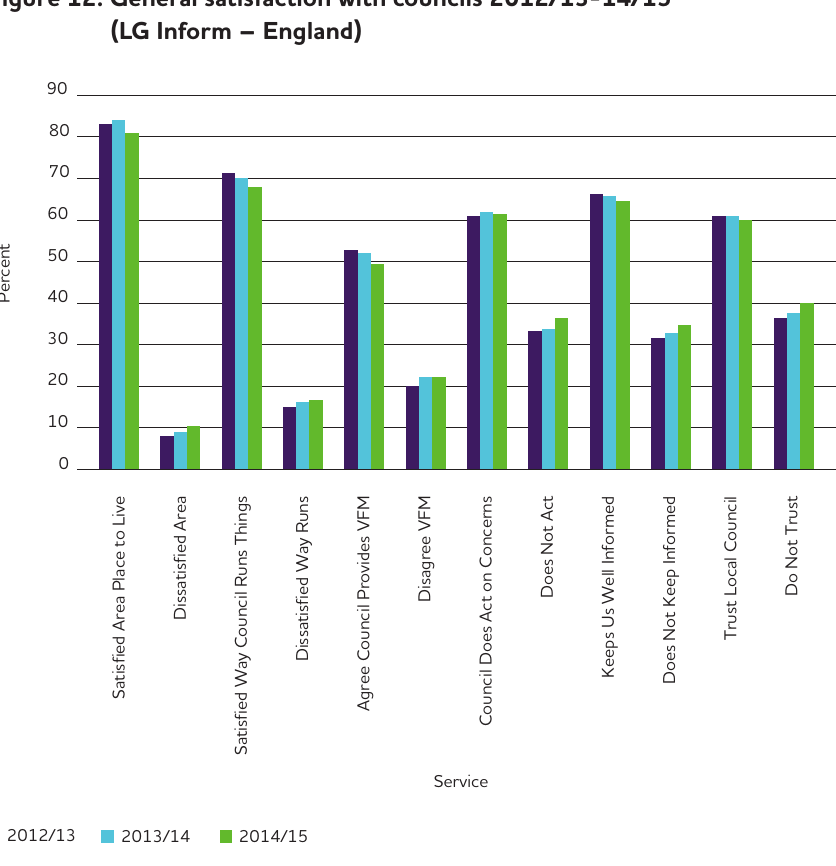
Figure 12: General satisfaction with councils 2012/13-14/15 (LG Inform –